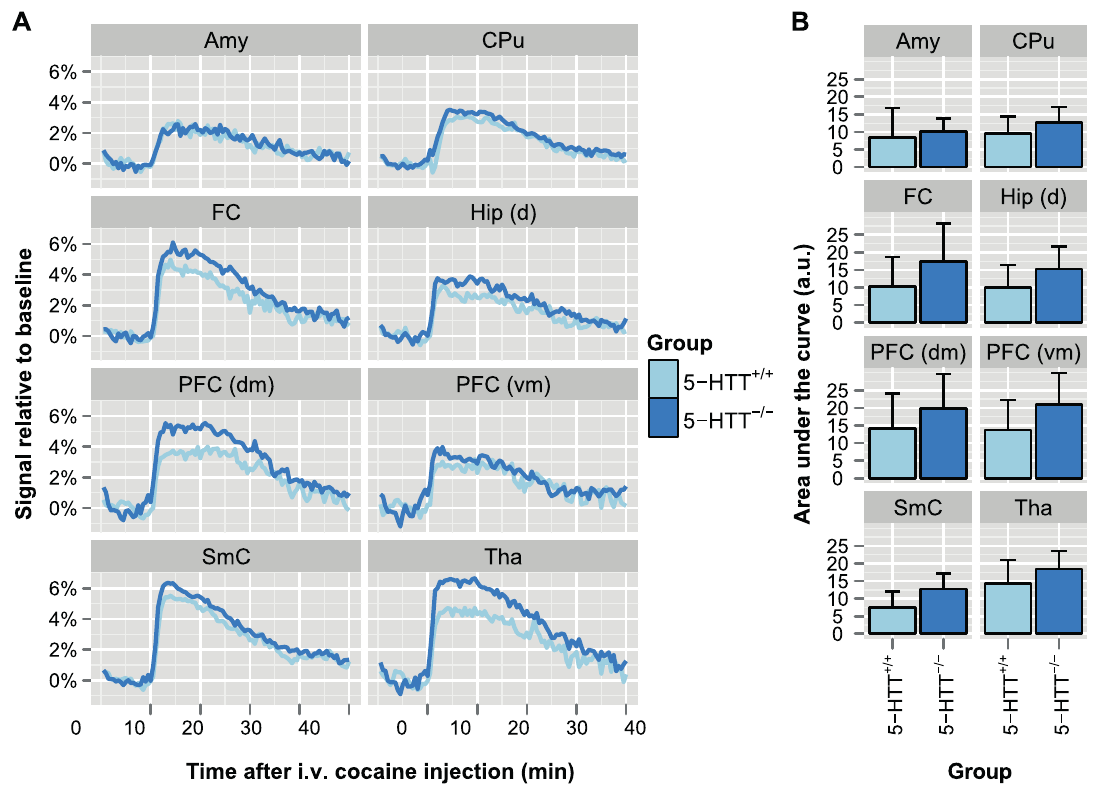
Figure 4. Cocaine-induced activation responses from seed-based analysis of pharmacological MRI. BOLD-based pharmacological MRI was performed for 50 minutes, with 1 mg/kg cocaine injected intravenously after 10 minutes. (A) The raw signal time-courses after preprocessing, and (B) the area-under-the curve of gamma-variate functions obtained with a Bayesian fitting routine, are displayed for a selection of seed regions. Amy : basal amygdaloid nuclei; CPu : caudate-putamen; FC : frontal cortex; Hip (d) : dorsal hippocampus; PFC (dm) : dorsomedial prefrontal cortex; PFC (vm) : ventromedial prefrontal cortex; SmC : somatosensory cortex; Tha : thalamic nuclei.